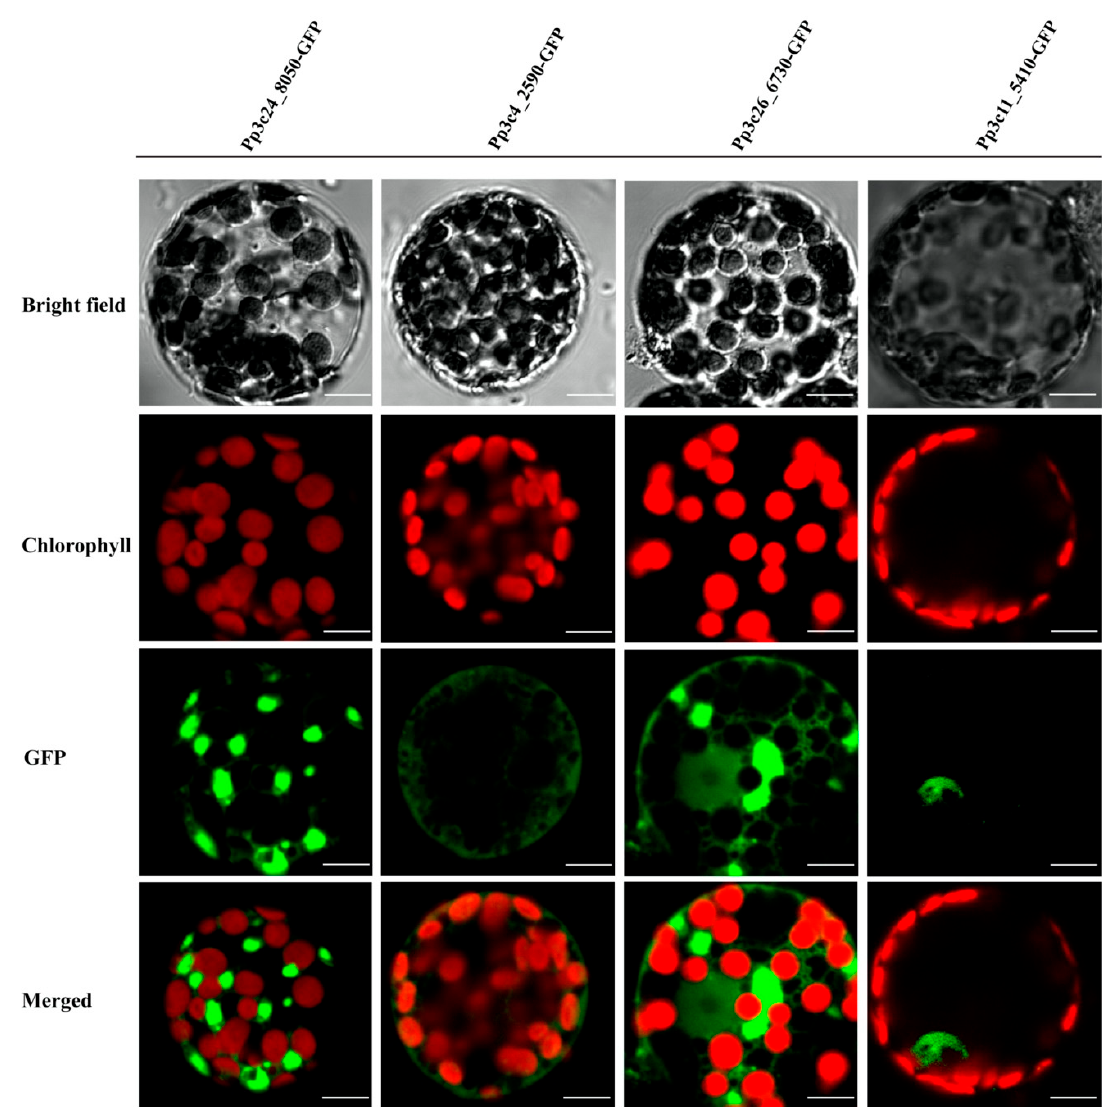
Figure 4. Subcellular localization of four different MYBs, Pp3c24_8050, Pp3c4_2590, Pp3c26_6730, and Pp3c11_5410, as indicated by green fluorescence. Subcellular localization of four different MYBs were analyzed, three of which (Pp3c24_8050, Pp3c4_2590, and Pp3c26_6730) are not localized to the nucleus, whereas 5410 (Pp3c11_5410) is localized in the nucleus as indicated by the green fluorescence. Scale bars, 10 μ m.